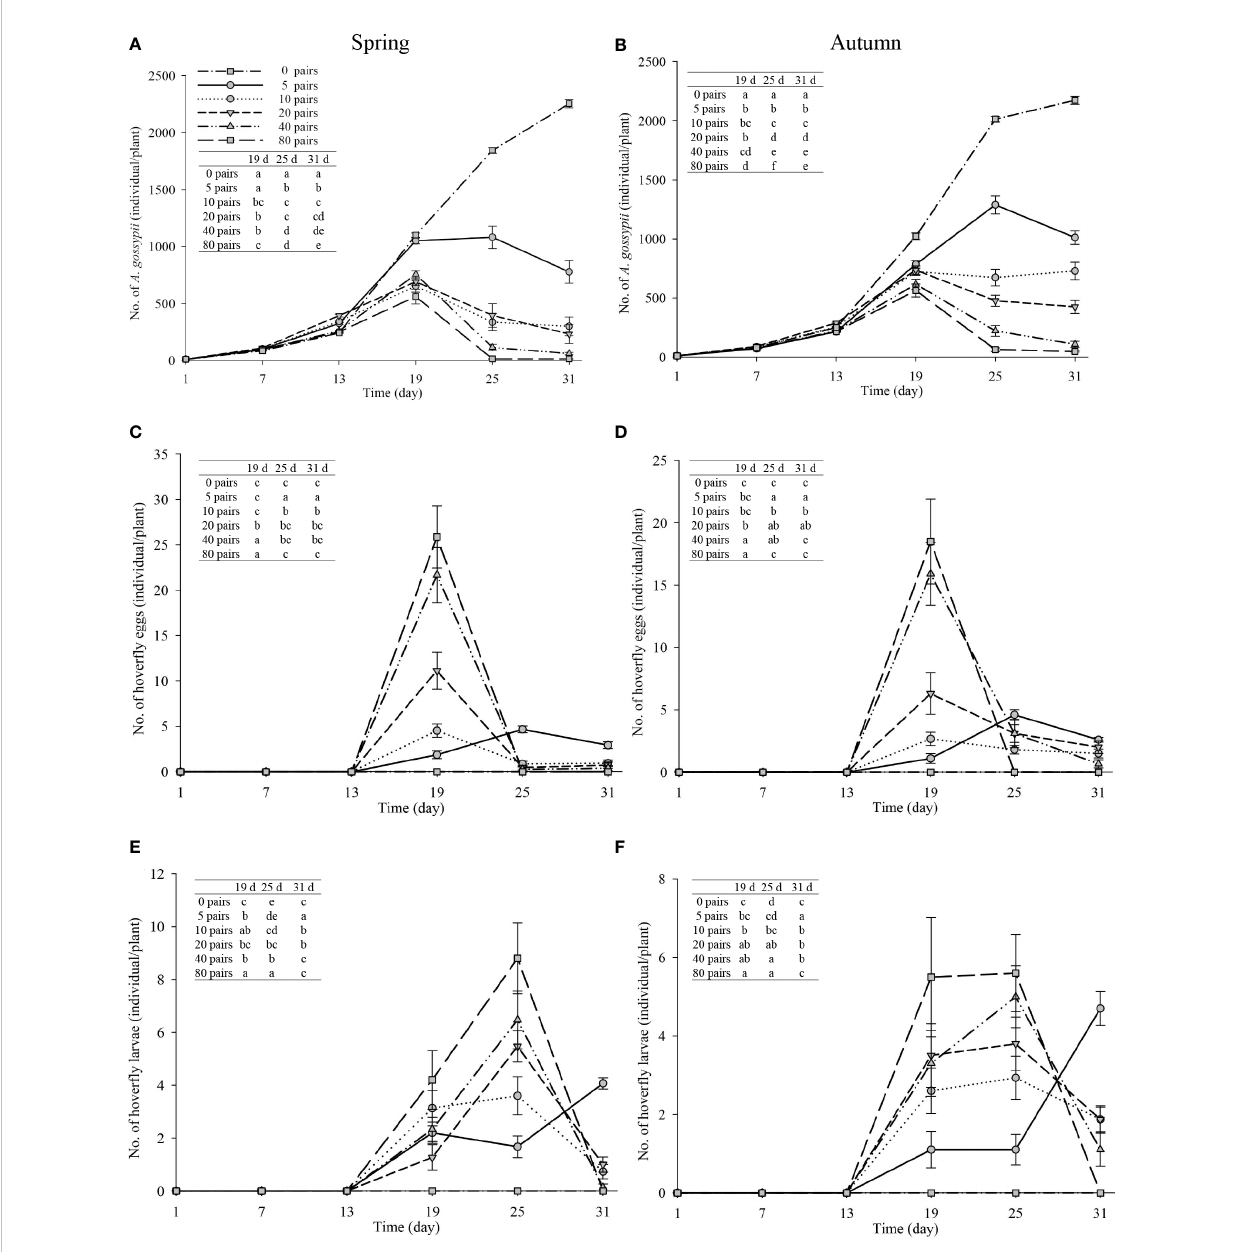
FIGURE 4 Number of A. gossypii (A, B) , hover fl y eggs (C, D) and hover fl y larvae (E, F) per muskmelon plant over time during spring and autumn 2020-21. Hover fl ies were released on day 7, 13, 19, 25 and 31. Mesh bags that covered individual aphid-infested plants were removed on day #13. Data are plotted for different hover fl y release rates i.e., 0 (i.e., hormone treatment), 5, 10, 20, 40 and 80 adult pairs. Different lowercase letters indicate statistically signi fi cant differences between treatment groups on the same time in each fi gure (One-way ANOVA, P <0.05, Tukey ’ s HSD post-hoc